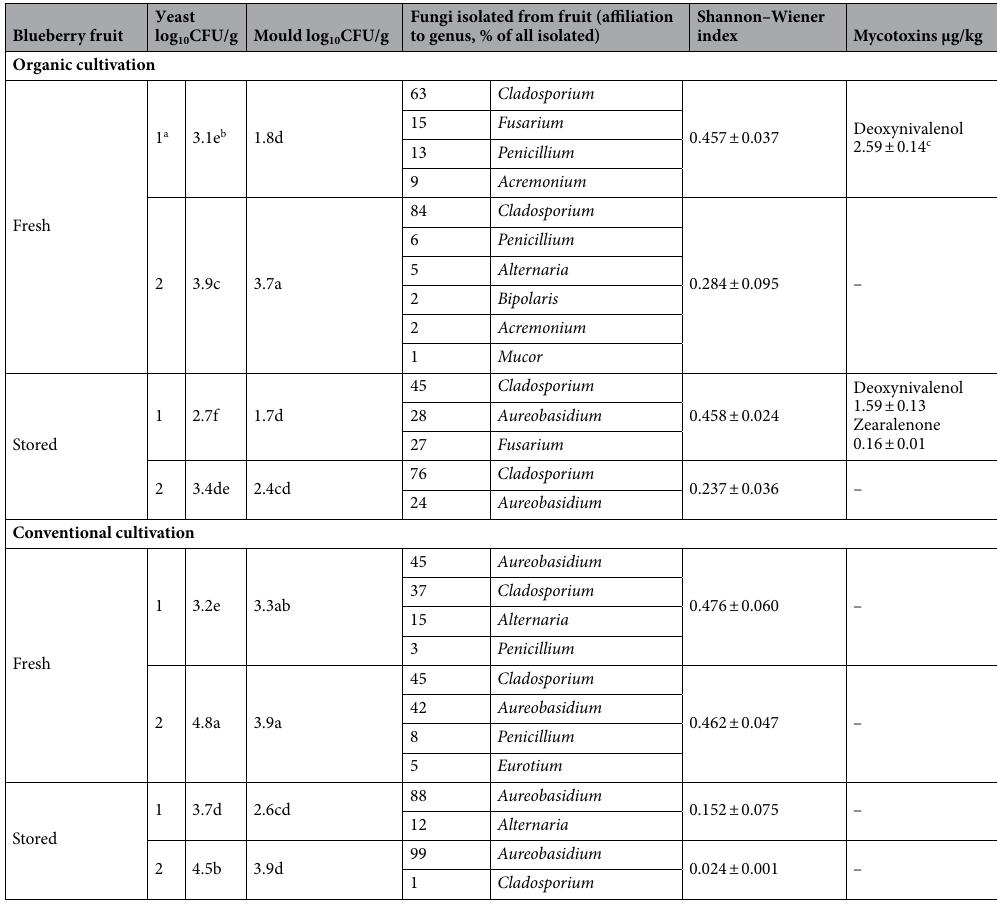
Table 1. Impact of the cultivation method and storage of blueberry fruit on the amount of yeast and mould and the composition and variety of fungi as well as the presence of mycotoxins in fruit. a 1–2 field number. b Values followed by the same letter, within the same column, were not significantly different (p < 0.05) according to t-Tukey test. c Mean values ±